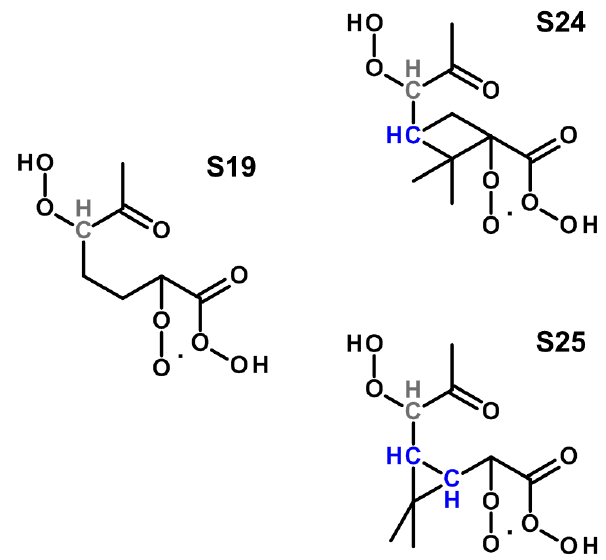
Figure 6. Comparison of deduced highest oxidized O 8 –peroxy rad- ical of 1-methyl cyclohexene (S19) to analogously constructed O 8 – peroxy radicals of α -pinene (S24) and (cid:49) -3-carene (S25). Tertiary H atoms in blue are explicitly shown. The H at the carbon atom carrying the hydroperoxy group, which is shifted in Reaction (R9c) is shown in gray. In an isomeric modification, the hydroperoxide group at C 3 could be located also at C 1